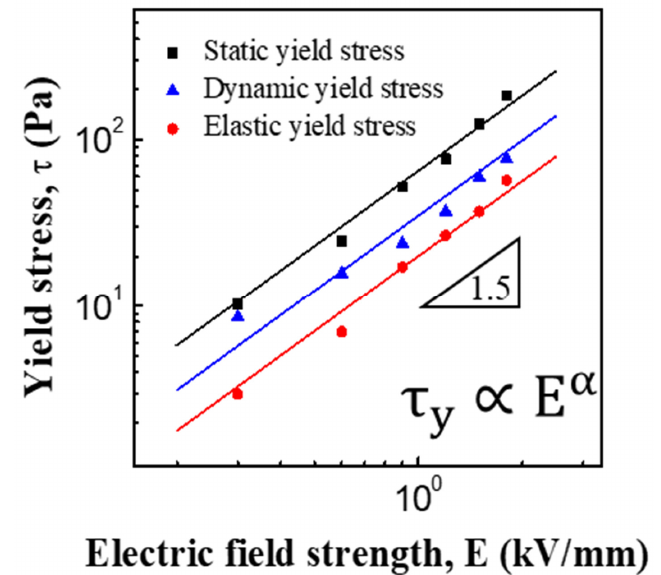
Figure 10. Yield stress vs. electric field strength curves of the GO / PDPA microsheet composites-based ER fluid (10 vol.%).